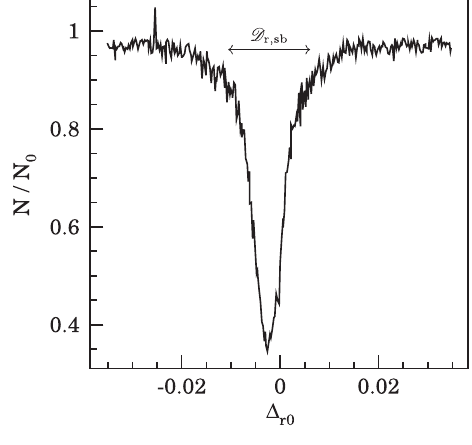
FIG. 11. Resonance